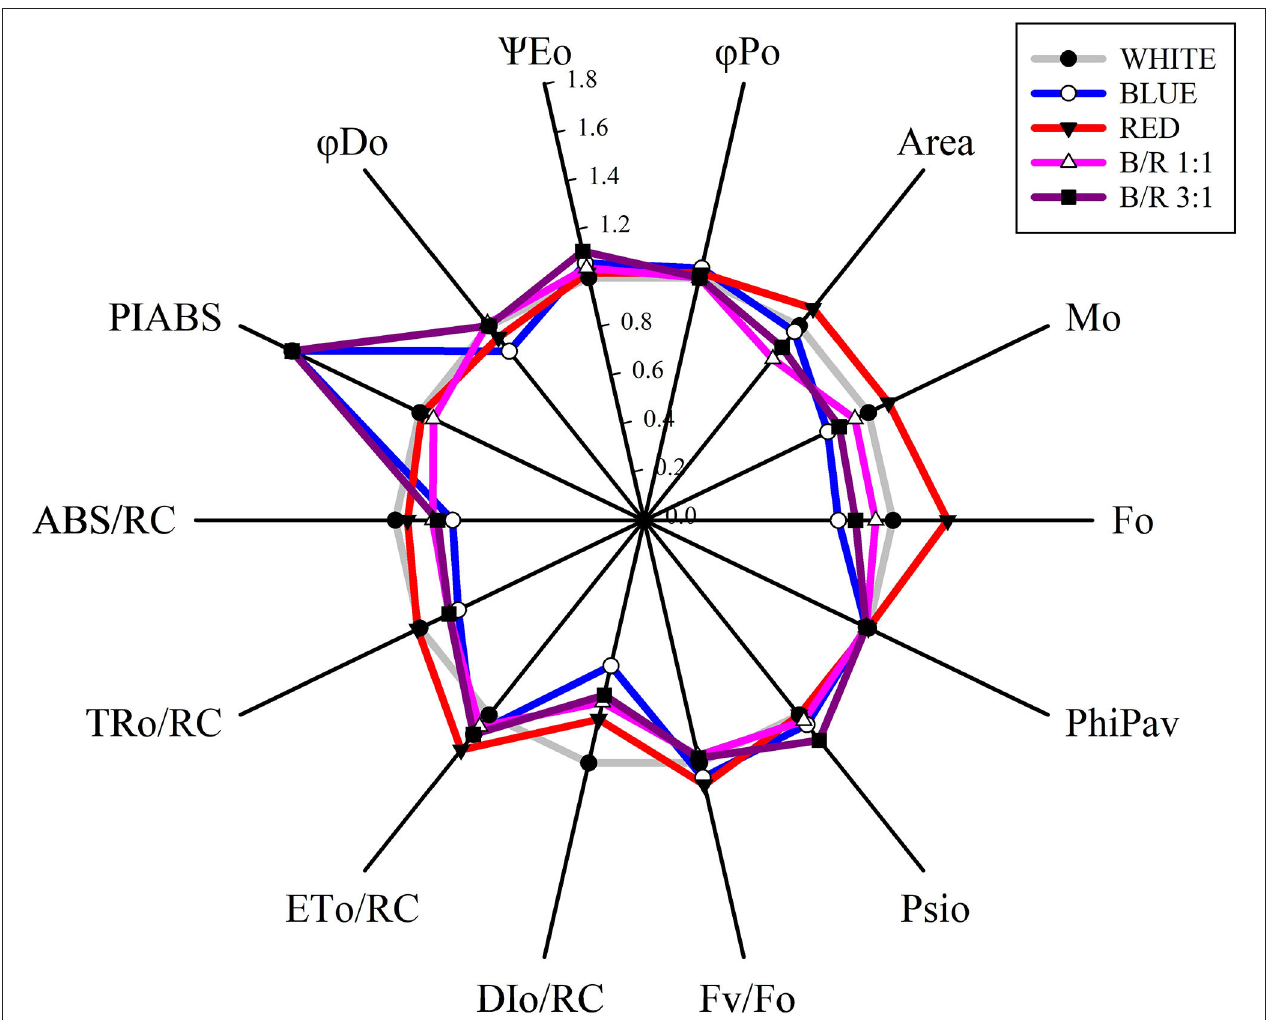
FIGURE 4 | Radar graph of JIP-test parameters as a function of white, blue, red, B/R 1:1 and B/R 3:1light spectra in Brosimum gaudichaudii seedlings at 50 days of in vitro cultivation. The average value of all parameters of the white treatment was considered as control (each parameter is equal to 1, denoted by the gray circle), and the other parameters in the other treatments were expressed by the fraction of the average value in the white treatment. Individual data points are the mean value of five seedlings.